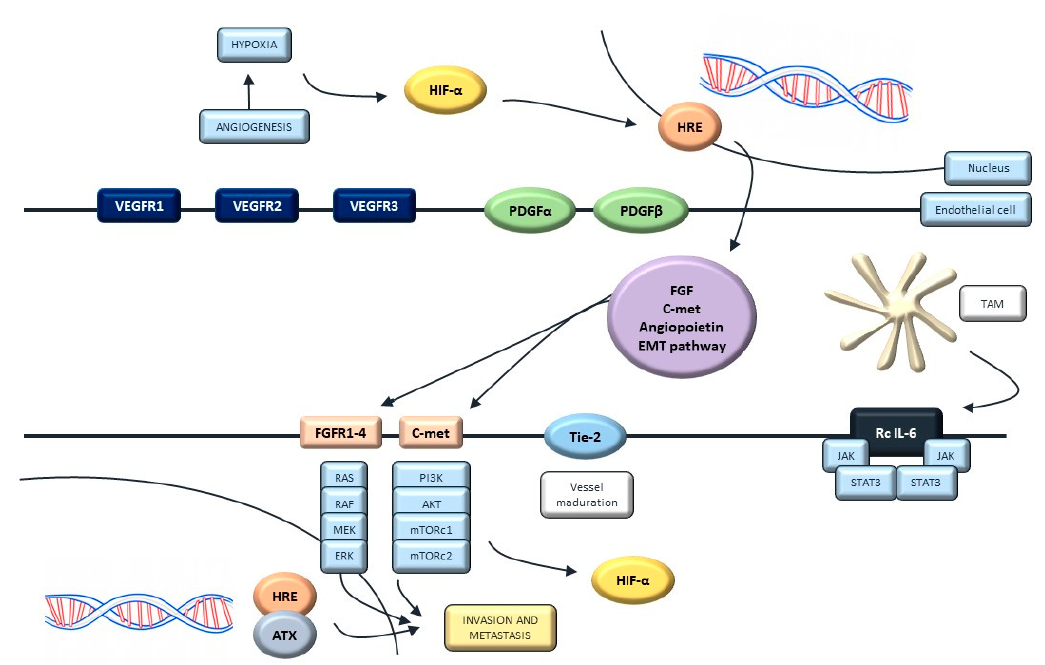
Figure 4. Angiogenesis pathways and their interaction with the MAP-K pathway.